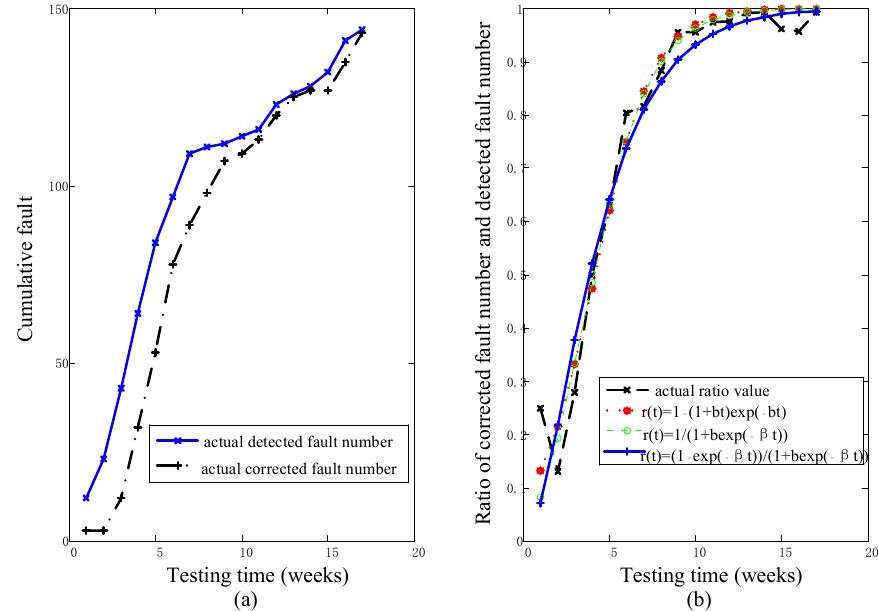
Figure 1. The cumulative number of faults detected and corrected with three function fitting results for the actual ratio on DS-1 ( a ) The actual cumulative number of detected faults and corrected faults for DS-1; ( b ) The actual ratio values and three function fitting results for the actual ratio on DS-1. Apparently, this phenomenon is better captured by an S-shaped function.